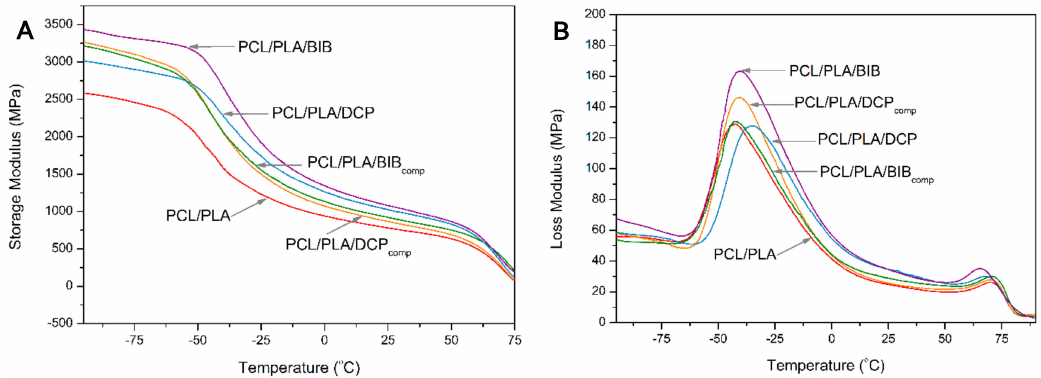
Figure 6. Storage ( A ) and Loss ( B ) Modulus of PCL / PLA blends.